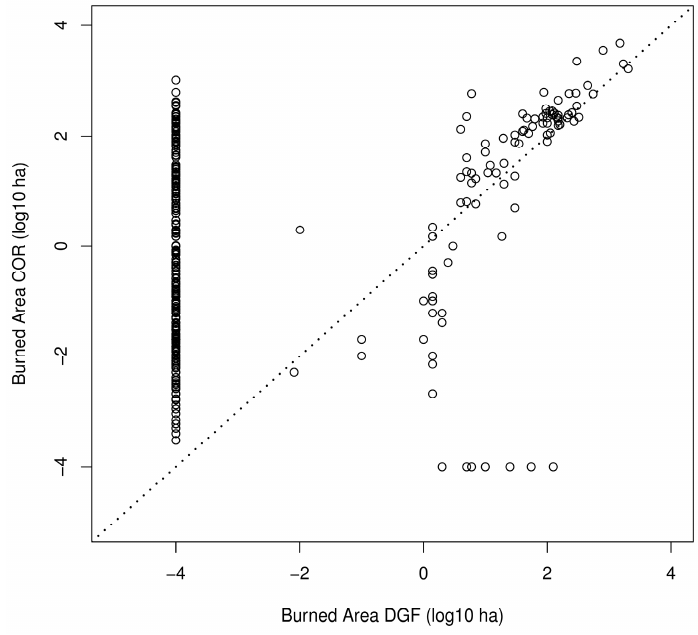
Figure 6. Scatterplot representing the corrected (COR) burned area of large fire events ( Y -axis, in ha, log10 scale) as a function of official burned area ( X -axis, in ha, log10 scale) from DGF.